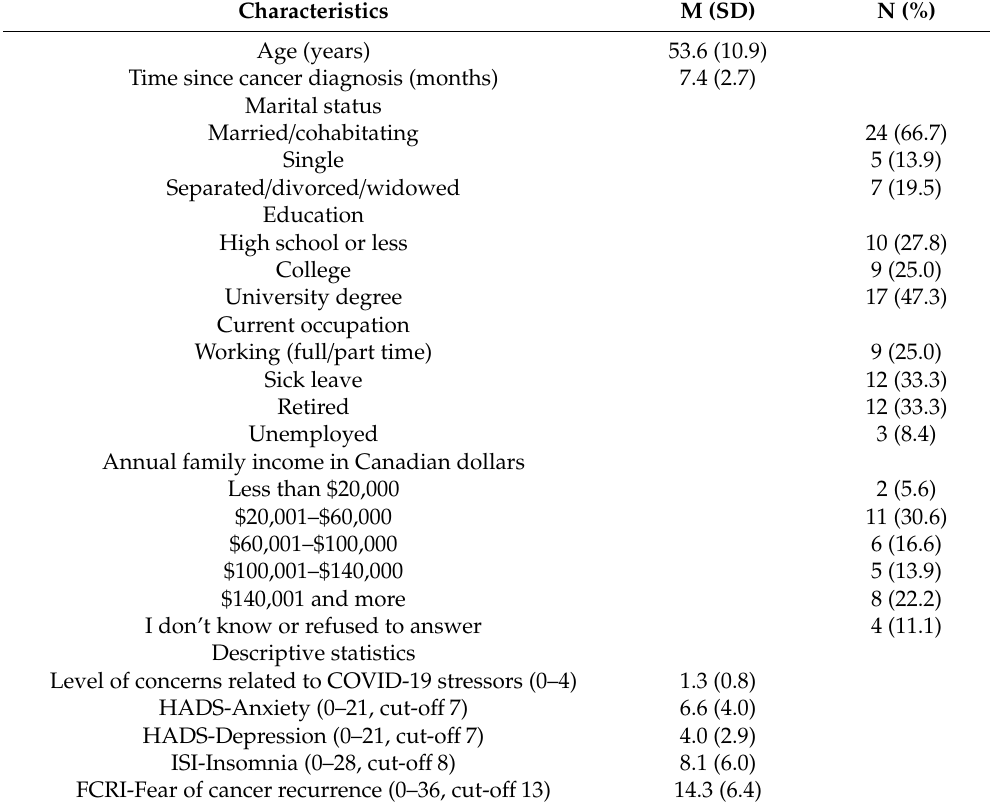
Table 1. Characteristics of participants and descriptive statistics (N =